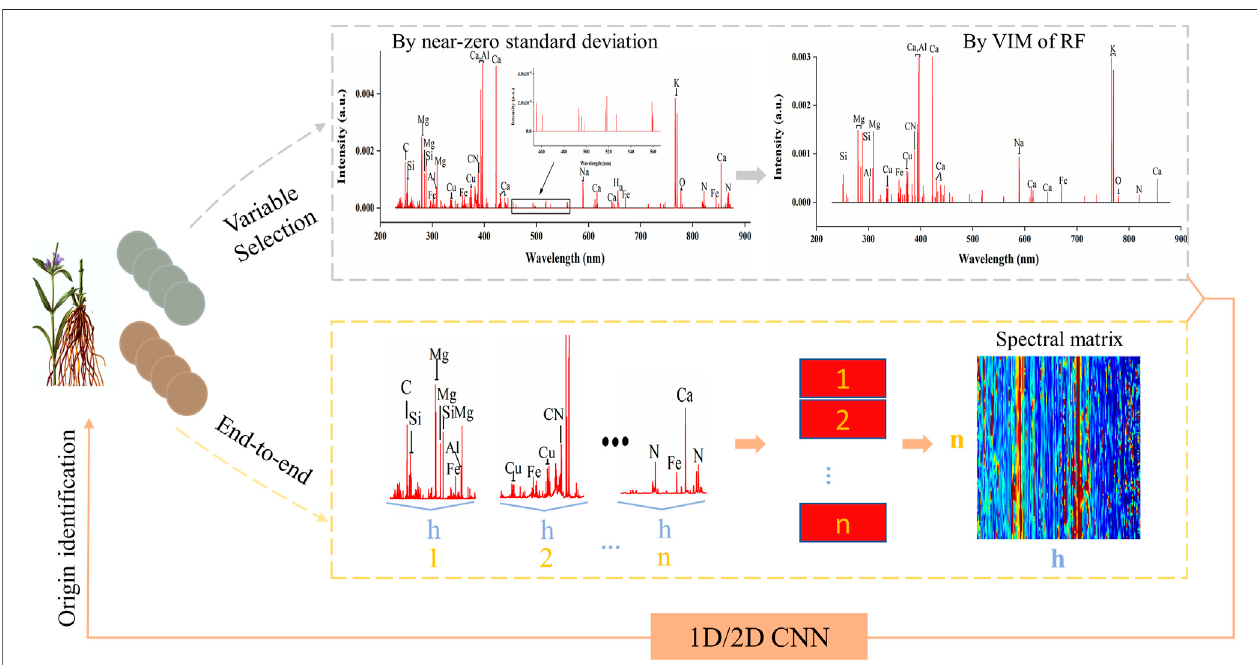
FIGURE 2 | The geographical origin identi fi cation fl owchart using convolutional neural network including variable selection and end-to-end learning based on spectral matrix.